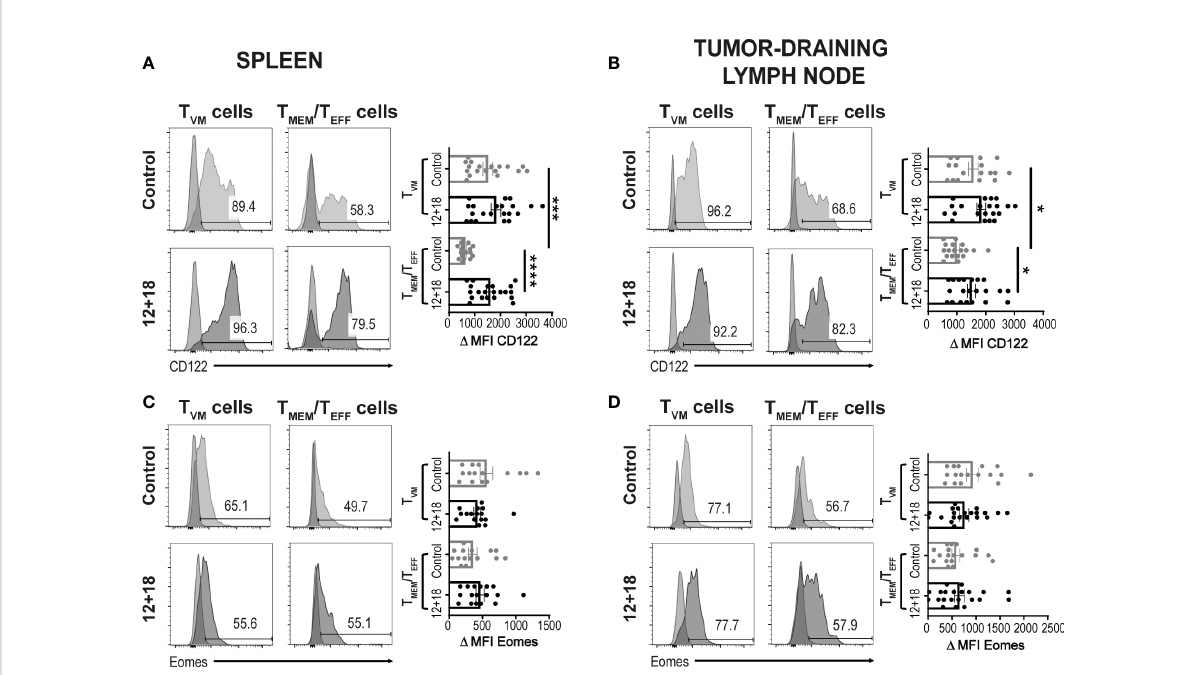
FIGURE 3 Effects of systemic co-expression of IL-12 plus IL-18 on T VM and T MEM /T EFF cells in SLO. B16-bearing C57BL/6 WT mice were hydrodynamically injected (HI) with IL-12 plus IL-18 cDNA (12 + 18) or empty cDNA as the control. After 7 days post-HI mice were euthanized, and spleen and tumor-draining lymph nodes (dLN) were harvested and processed for fl ow cytometry. Histograms and their respective bar graphs represent (A, B) CD122 or (C, D) Eomes frequencies and D medium fl uorescence intensity (MFI) of T VM (left histograms) and T MEM /T EFF cells (right histograms) from control (upper histograms) or 12 + 18 mice (lower histograms) on (A, C) spleen or (B, D) dLN. D MFI was calculated as CD122 or Eomes MFI minus MFI from their respective isotype controls. Statistical analysis was performed with One-way ANOVA test (B) or Kruskall Wallis test (A, C, D) . Values of *p<0.05, ***p<0.001 ****p<0.0001 were consider signi fi